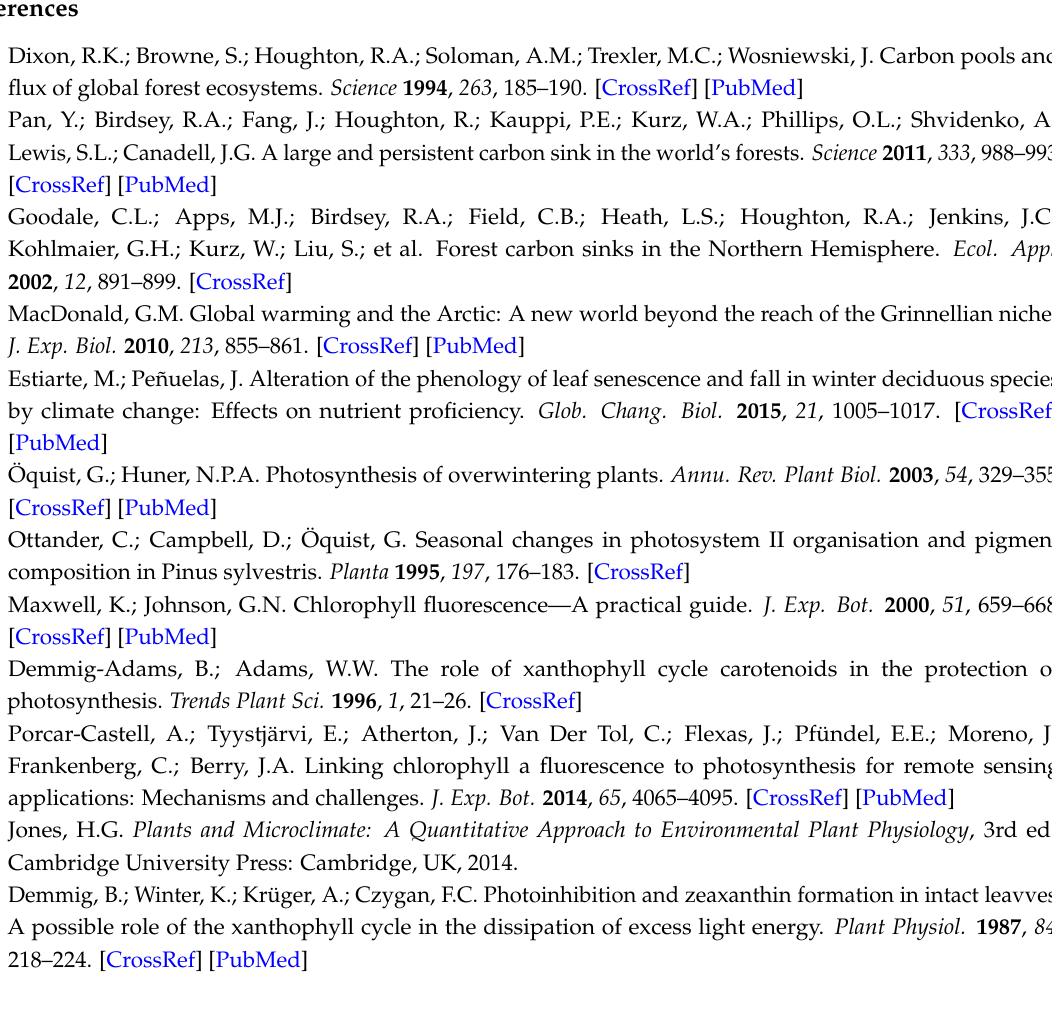
Figure S1: Correlations between daily average temperature, photosynthetic rate ( µ mol CO2 m − 2 s − 1 ), NDVI, PRI, CCI, or fluorescence for evergreen (a–e) and deciduous (f–j)